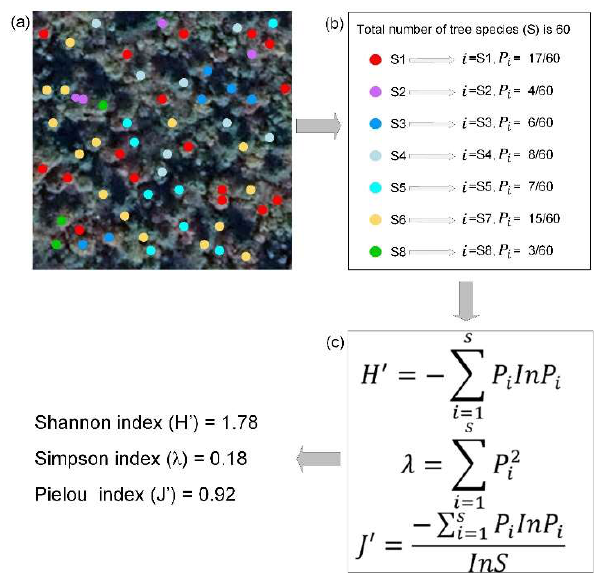
Figure A2. Illustrations of forest tree species diversity calculated by the three indices ( H ′, J ′ and λ). a. Plot with tree species information; b. Statistics on the number and types of tree species in the plot; c. Calculation equation of tree species diversity. In Fig. A2c, S is the total number of tree species in a plot; 𝑃 (cid:3036) is the proportional abundance of species 𝑖 relative to the total abundance of all species 𝑆 in a plot; 𝐼𝑛𝑃 (cid:3036) is the natural logarithm of this proportion.